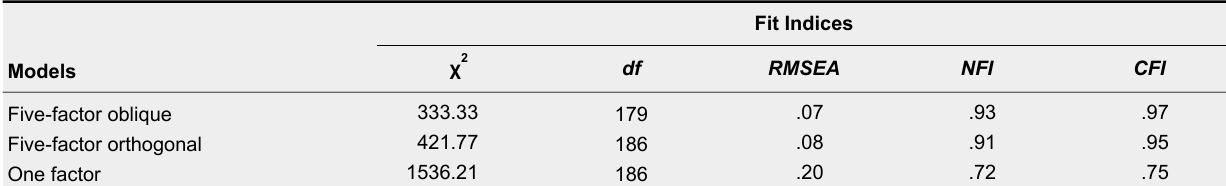
Comparison of Fit Indices of the First Model (Five-Factor Oblique), the Second Model (Five-Factor Orthogonal), and the Third Model (One